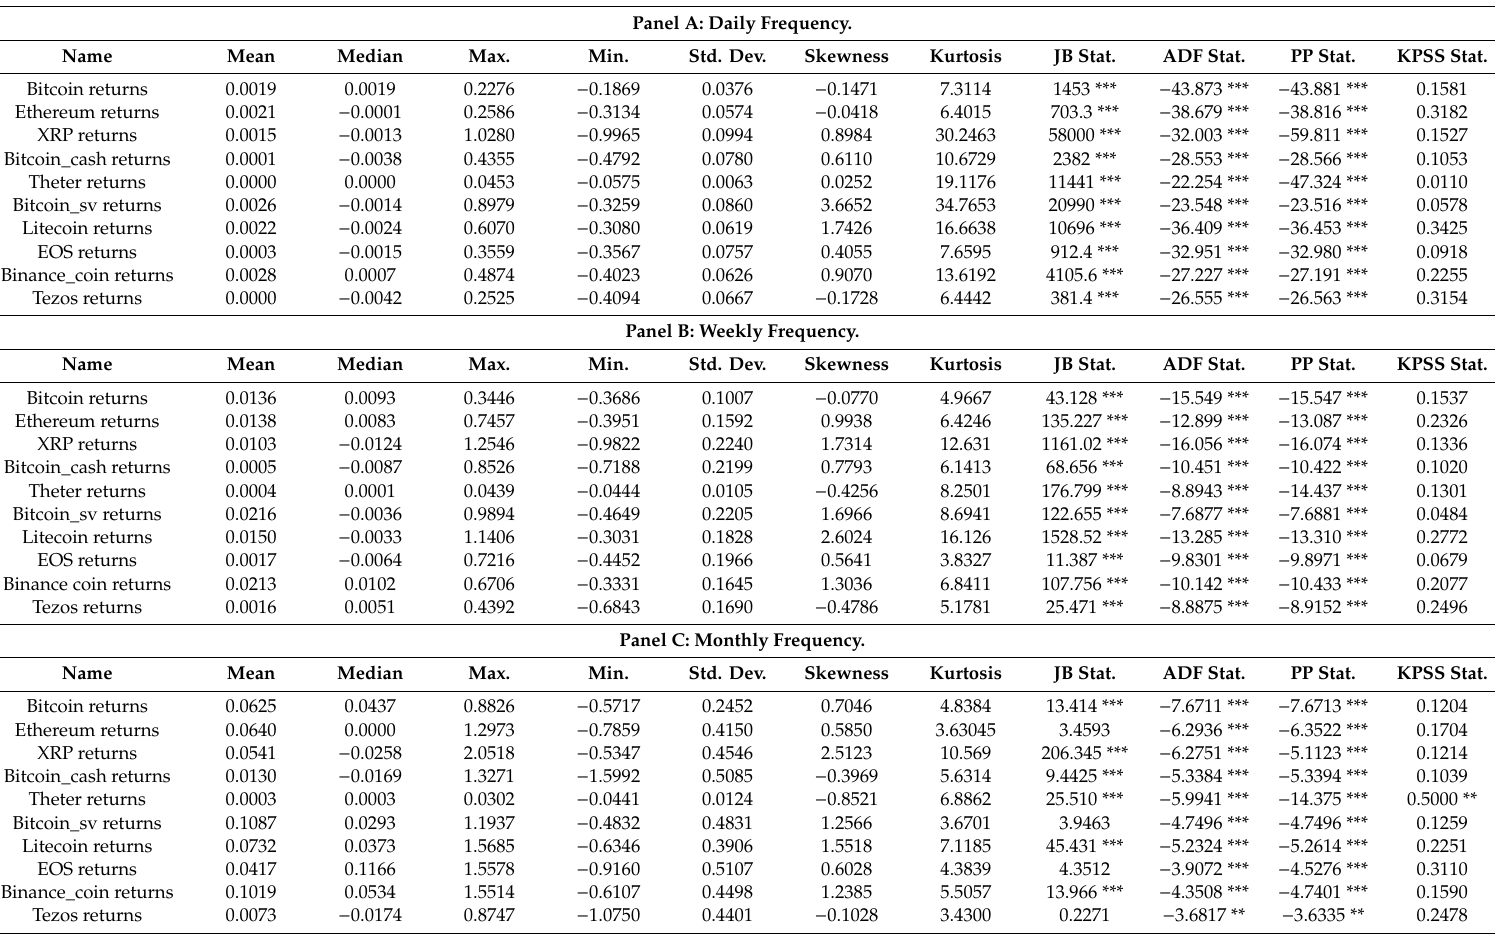
Table 2. Descriptive statistics of Bitcoin returns and returns of the rest of the top ten cryptocurrency returns. 1